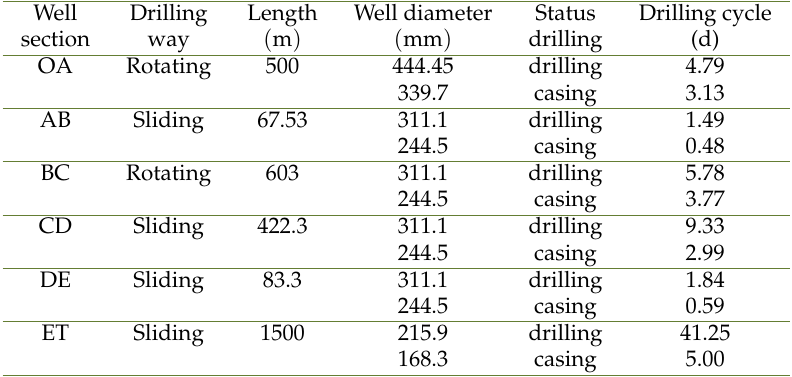
Table 10. Expected drilling time of modified six-section well path